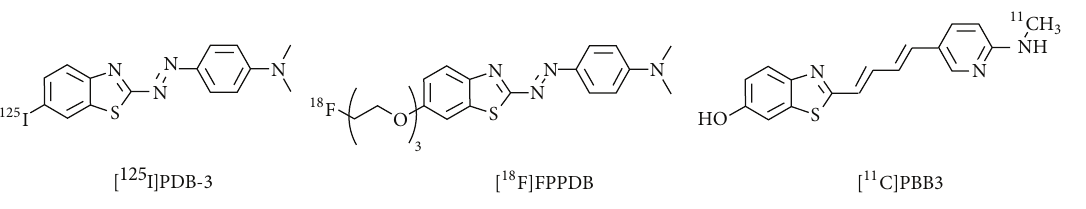
Figure 4: Chemical structures of benzothiazole derivatives for the imaging of tau